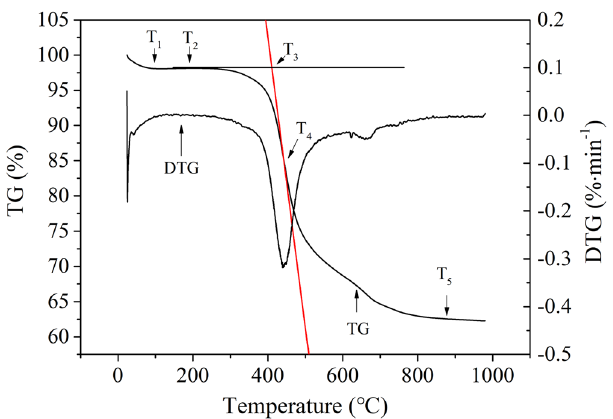
Figure 2. TG curves of the coal